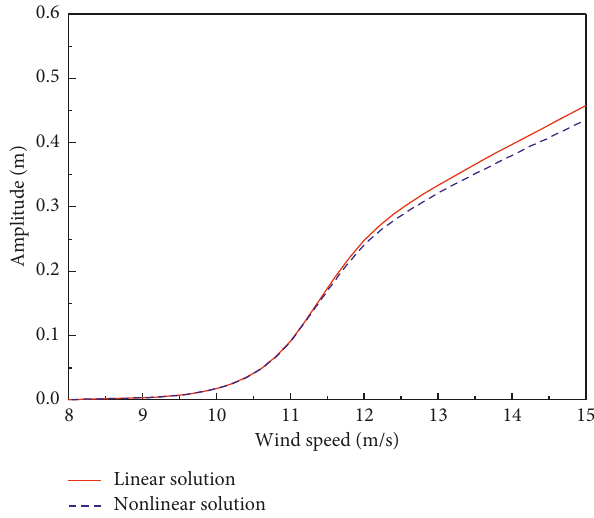
Figure 11: Comparison of the galloping amplitude of m solution and nonlinear